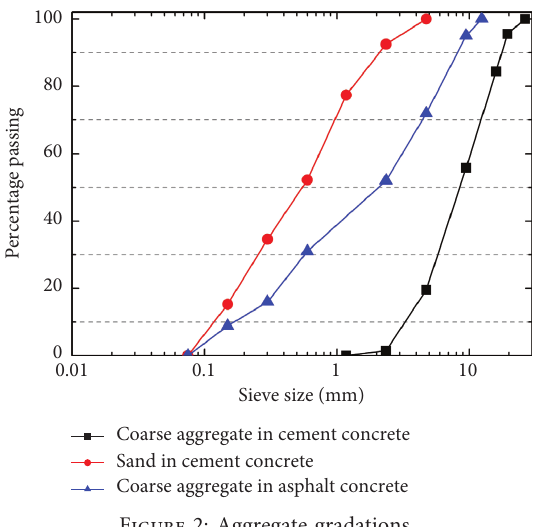
Figure 2: Aggregate gradations.